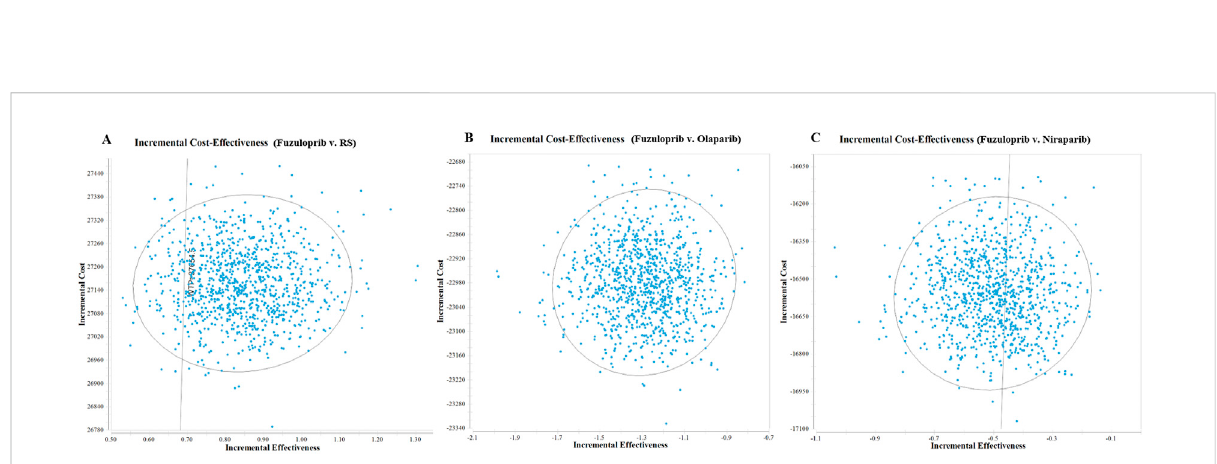
FIGURE 3 1,000 monte carlo simulation diagram ofthe probabilisticsensitivity analysis. (A) is theresult of fuzuloparibvs. RS, (B) isthe result of fuzuloparib vs. olaparib, and (C) is the result of fuzuloparib vs. niraparib. RS, routine